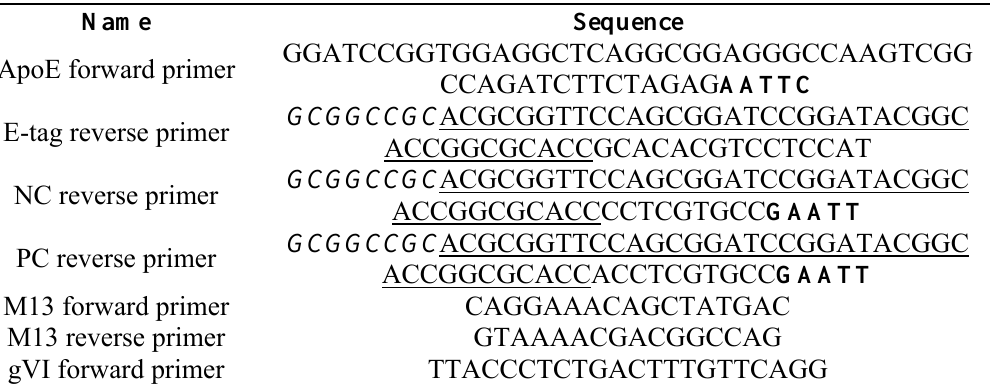
Table S1. Primers used in the